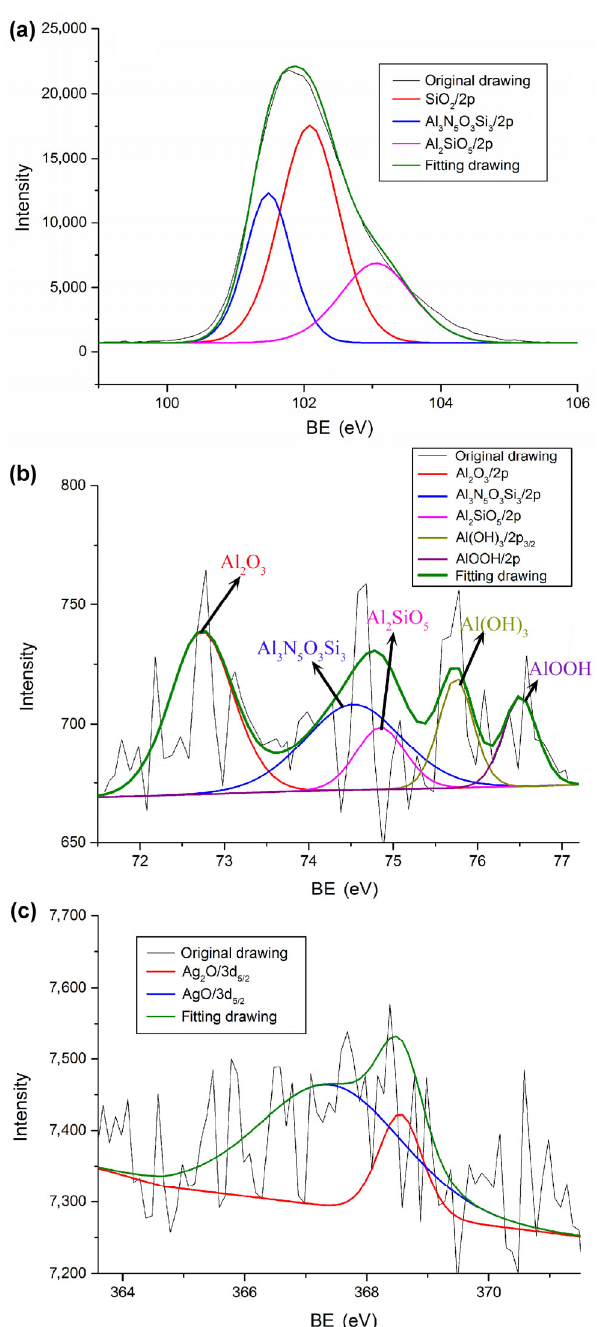
Fig. 7 XPS spectra of element Si, Al, and Ag in abrasives con- taining Ag-doped colloidal SiO 2 with 1.5 wt% Ag 2 O after polishing: (a) Si 2p, (b) Al 2p, and (c) Ag